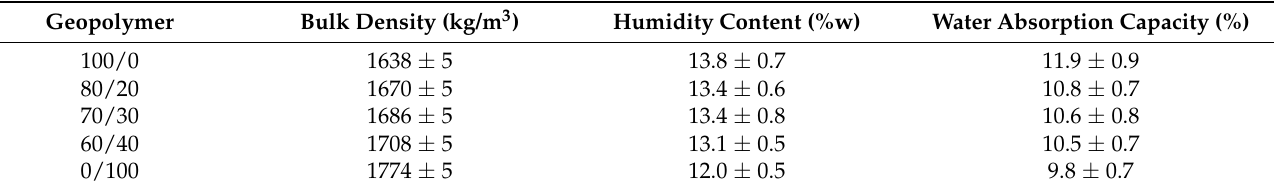
Table 4. Physical properties